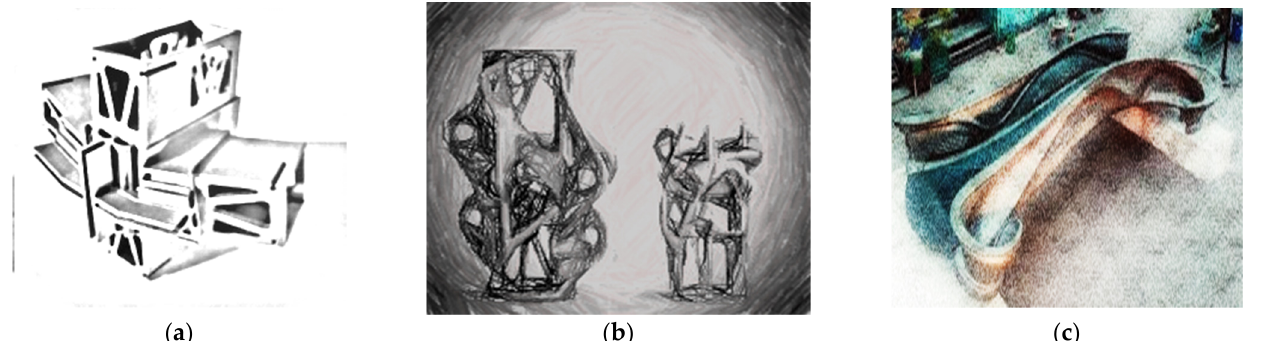
Figure 3. Examples of 3D printed metal elements: ( a ) aluminum node; ( b ) optimized nodes; ( c ) bridge MX3D. Images created by A. Skoratko (inspired by [43,45,46]).